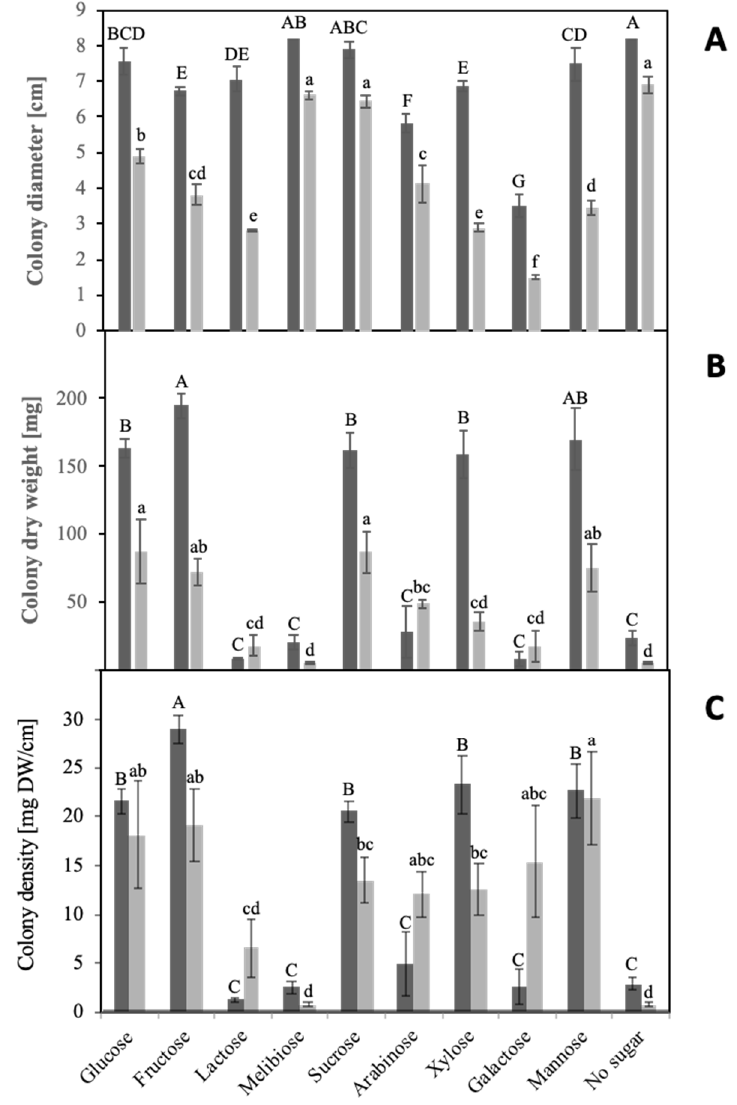
Figure 1. Growth patterns. Serendipita indica (dark grey columns) and Serendipita herbamans (light grey columns) were grown on Petri plates for 14 days with different sugar sources. Colony diameters ( A ) and dry weights ( B ) were measured, and colony densities ( C ) were calculated. Mean values are shown with standard errors as bars. Significance of differences of growth parameters between different sugar sources were analyzed for the two fungi independently and are indicated by different lower- or upper-case letters, respectively (HSD Tukey Test; n = 5).